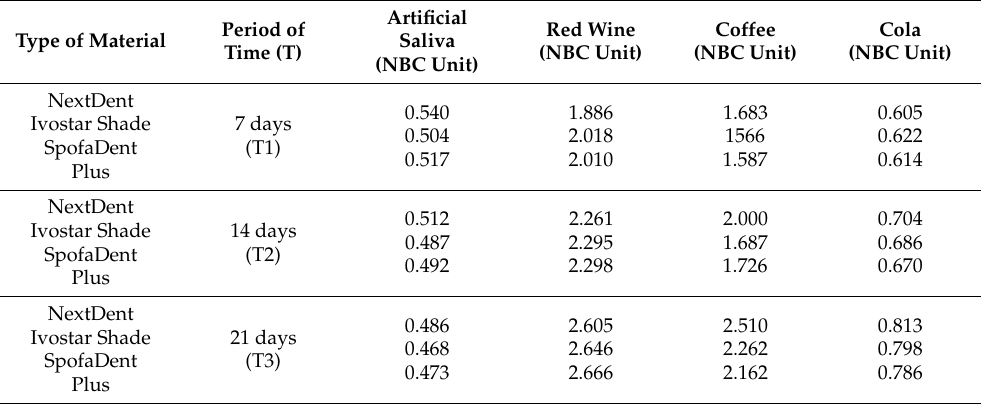
Table 6. Colour changes over time in different types of denture teeth (NBC Unit).